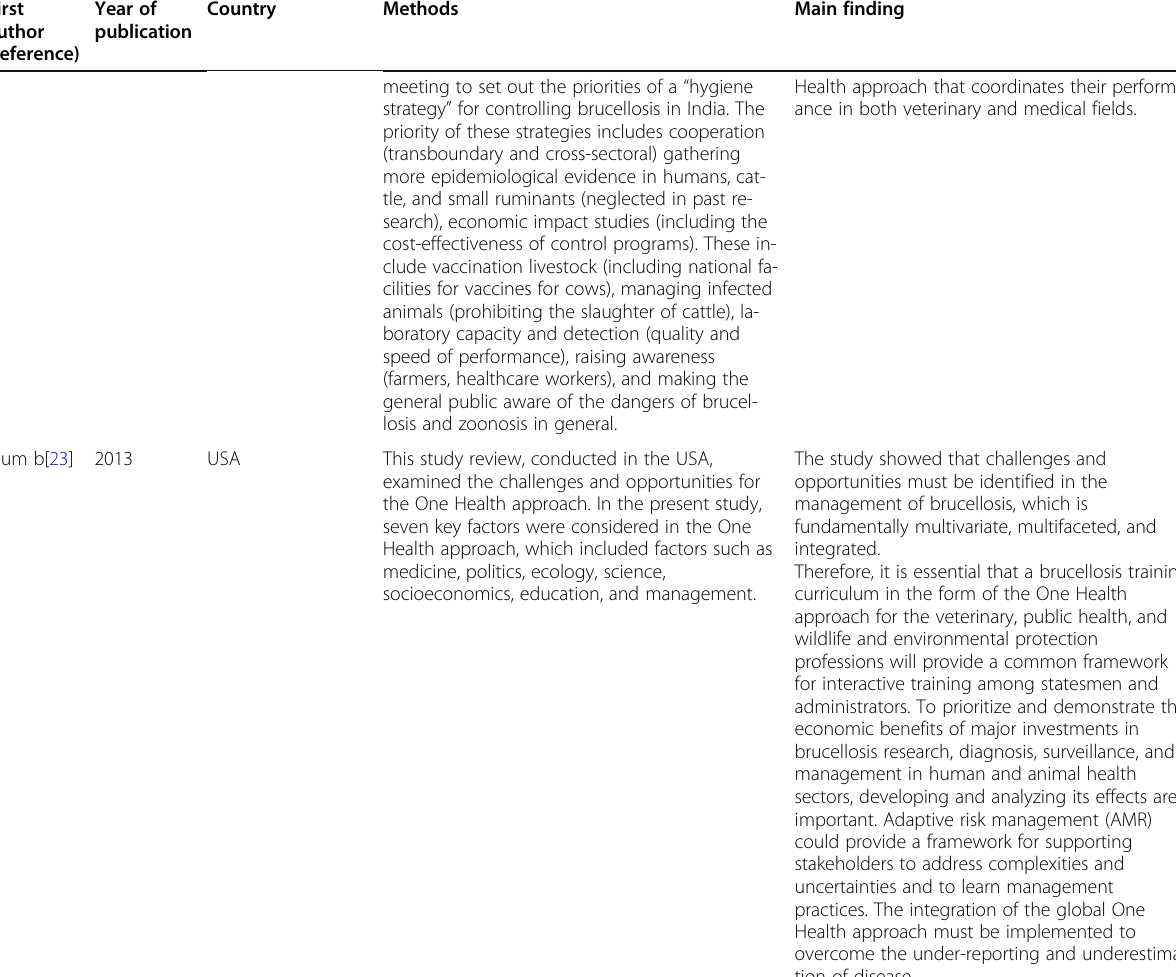
Table 1 Characteristics of the included studies (Continued)